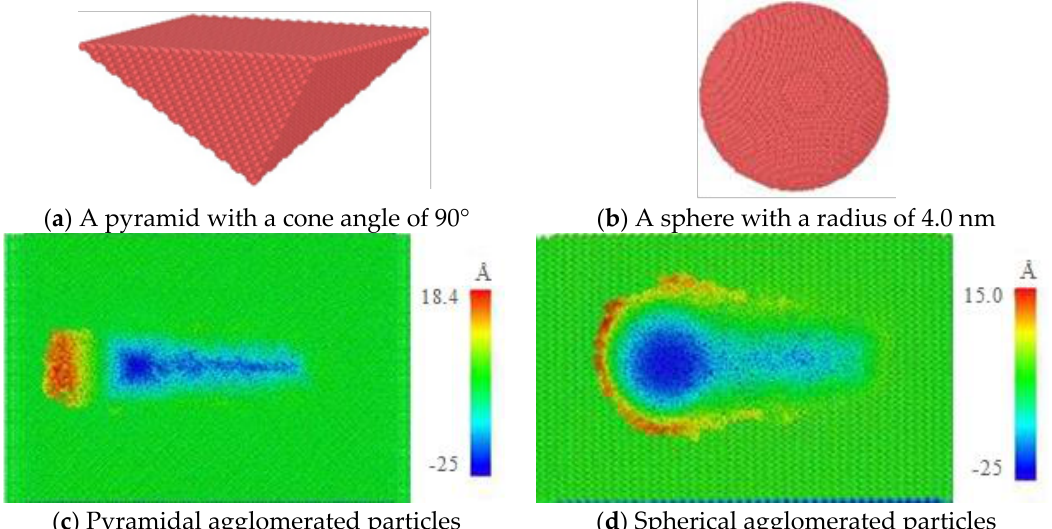
Figure 7. Scratch damage of agglomerated particles with different shapes.